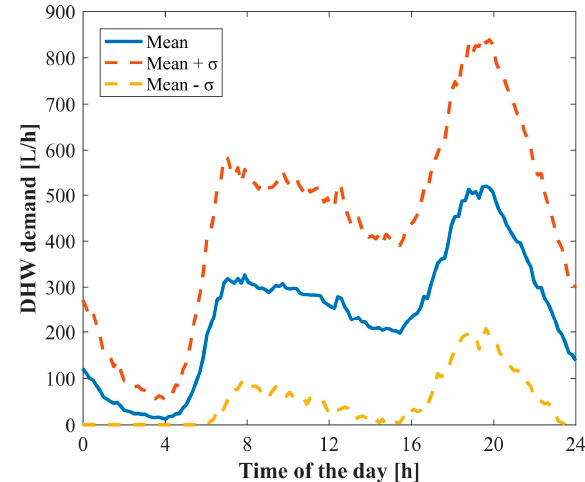
Figure 1. Mean domestic hot water demand profile throughout the